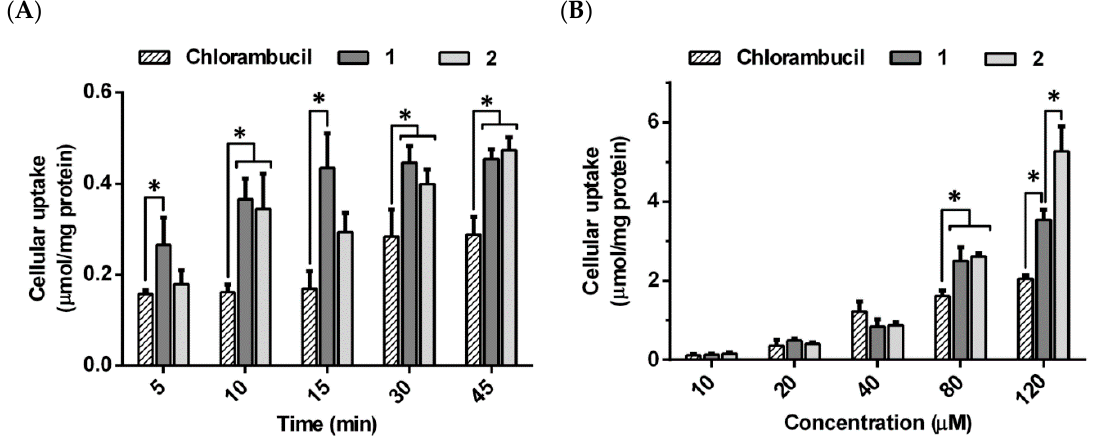
Figure 4. Cellular uptake of chlorambucil and its derivatives 1 and 2 at different incubation times ( 20 μ M ) ( A ) and different concentrations ( 15 min ) ( B ) in MCF ‐ 7 cells . Values expressed as mean ± SD ( n = 3 ). * p < 0 . 05, significant difference compared to chlorambucil at relevant times and concentrations .